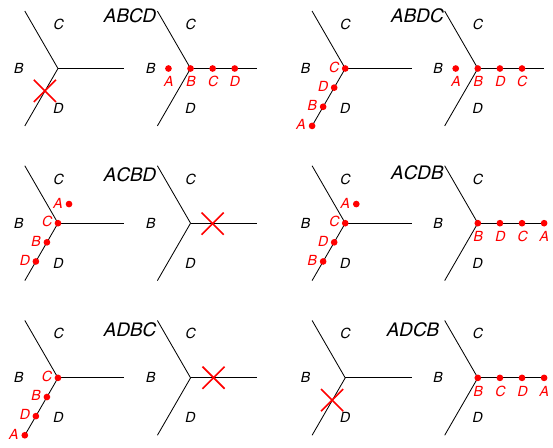
FIG. 16. Existence and nonexistence of solution to the straight line condition in Eq. (D23). For a given ordering abcd , the left-hand panel shows a solution (if it exists) with y < 0 and the right-hand panel shows a solution (if it exists) D > 0 . For instance, with abcd ¼ ABCD , straight line with y D > 0 . This analysis leads us solutions are allowed only when y D from Eq. (D34) to Eq.